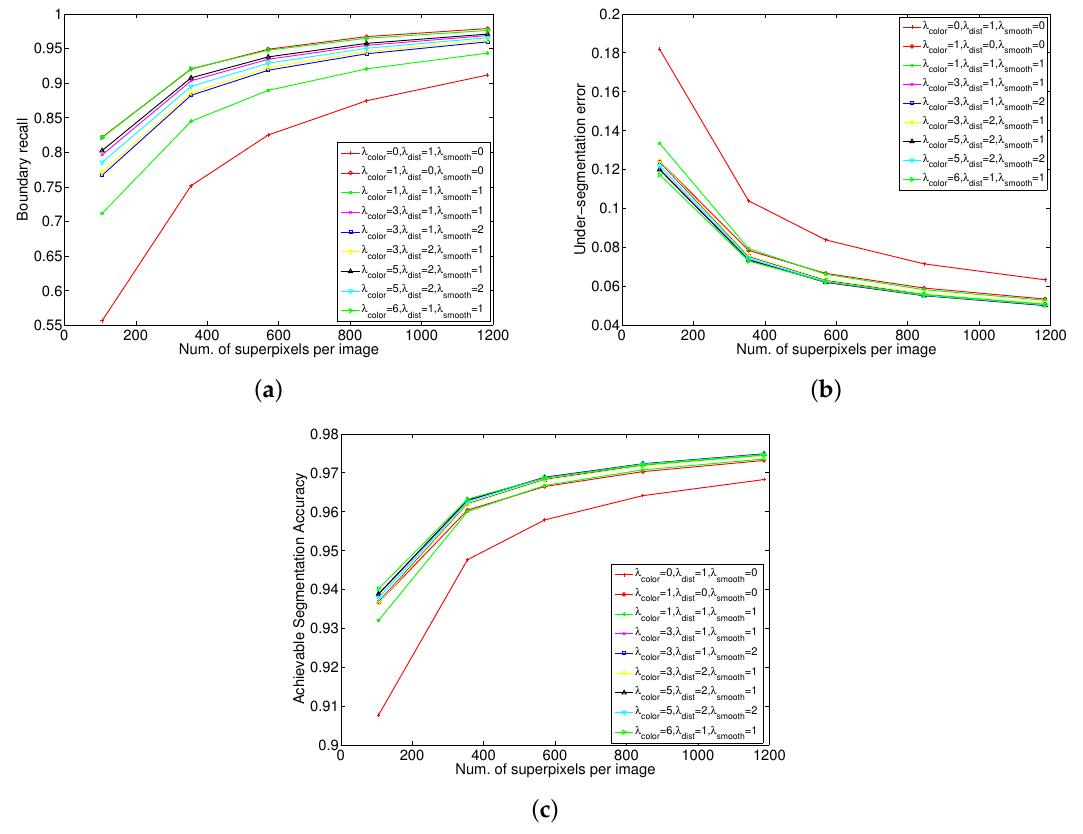
Figure 10. Performance comparison of the proposed algorithm under different parameter configurations. ( a ) Boundary recall; ( b ) Under-segmentation Error; ( c ) Achievable segmentation